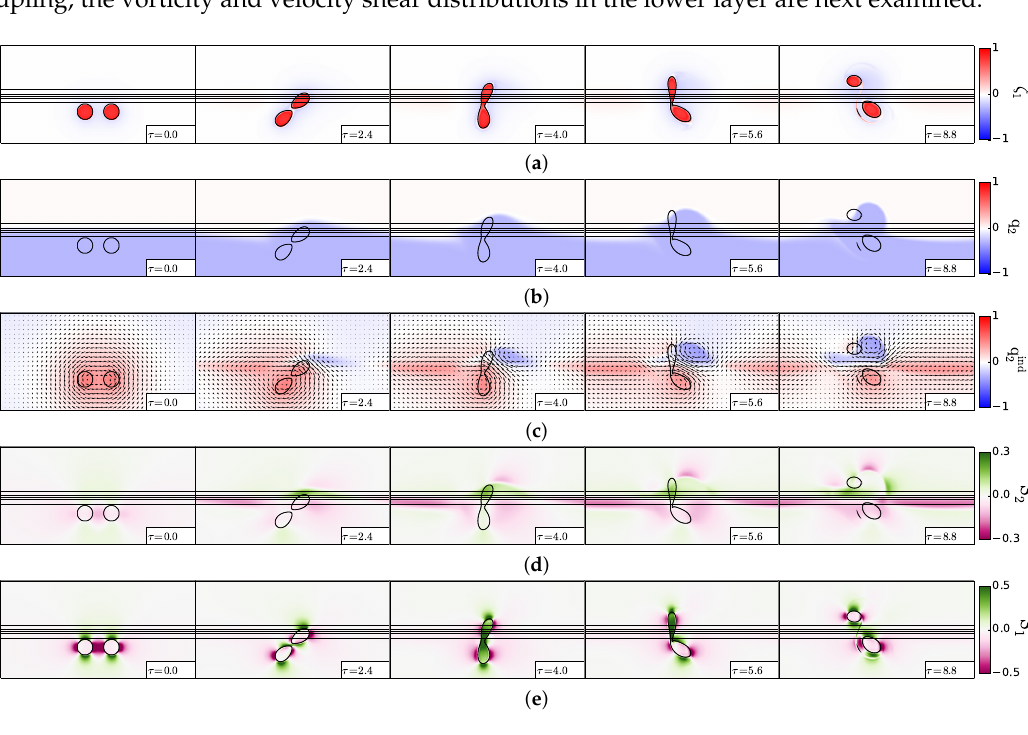
Figure 5. Partial merger of two cyclones, case d / R = 3.4, γ R = 1, d c / R = 2. ( a ) Upper layer relative vorticity (Equation (3)); ( b ) lower layer potential vorticity (Equation (2)); ( c ) lower layer “equivalent barotropic” potential vorticity and velocity field (Equations (4) and (11)); ( d ) lower layer velocity shear (Equation (5)); ( e ) upper layer velocity shear (Equation (5)). In (a,b,d,e), the black contours indicate the topographic slope (Equation (12); straight lines) and the upper layer vorticity contours showing the two vortex evolution. In each plot, x varies between − 2 π and + 2 π , and y varies between 0 and + 2 π